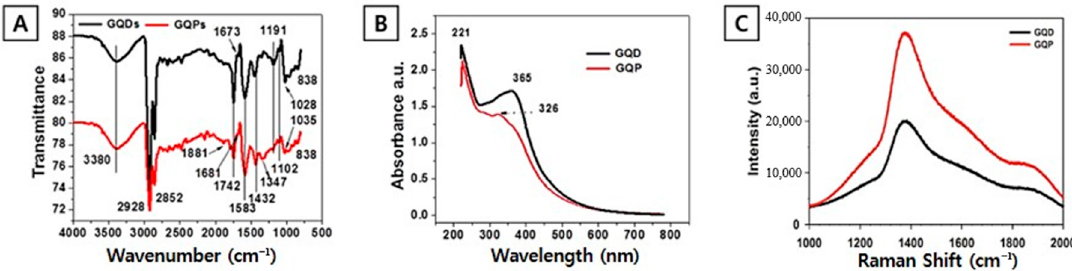
Figure3. SpectralanalysisofobtainedGQPsandGQDs. ( A )FT-IRspectroscopy, ( B )UV-visspectroscopy, Figure 3. Spectral analysis of obtained GQPs and GQDs. ( A ) FT-IR spectroscopy, ( B ) UV-vis ( C ) Raman Spectroscopy. Nanomaterials 2020 , 10 , x FOR PEER REVIEW spectroscopy, ( C ) Raman Spectroscopy.